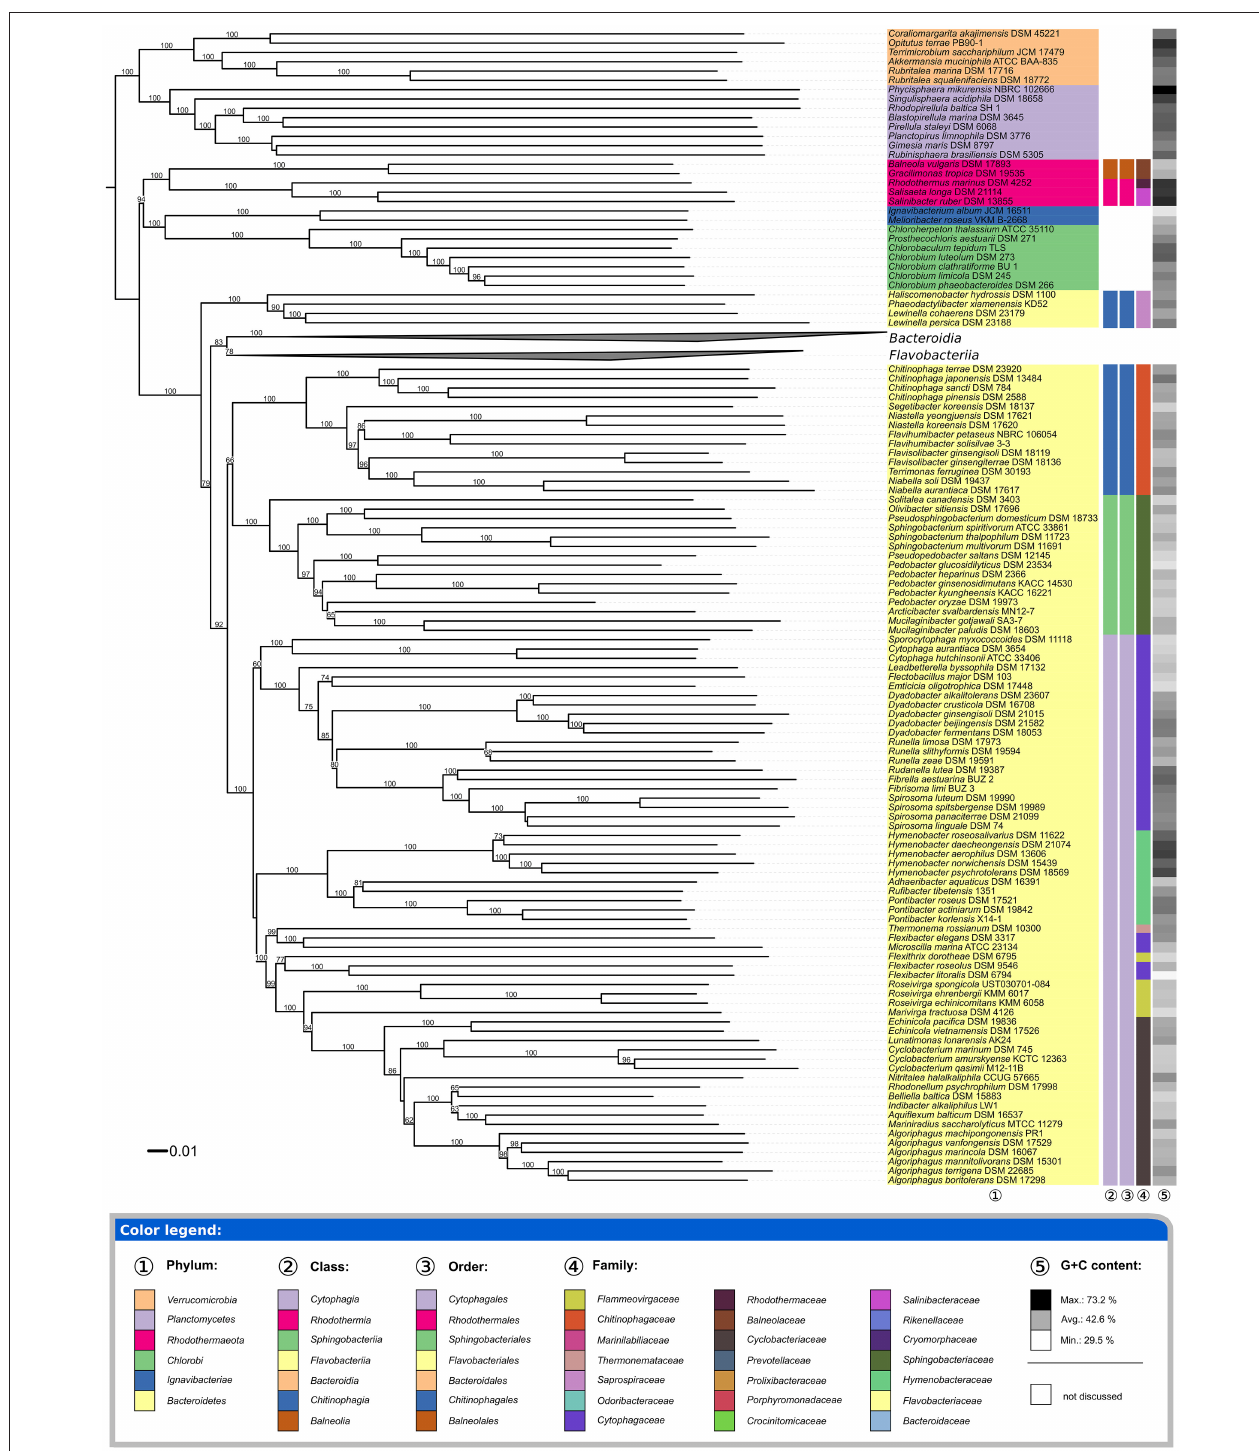
FIGURE 2 | First part of the phylogenomic tree inferred with GBDP. Tree inferred with FastME from GBDP distances calculated from whole proteomes. The numbers above branches are GBDP pseudo-bootstrap support values from 100 replications. Tip colors indicate the phylum, colors to the right of the ingroup tips indicate, from left to right, class, order and family (see the embedded legend for details). Gray scale on the very right indicates the exact G + C content as calculated from the genome sequences. The Bacteroidia and Flavobacteriia parts of the tree, which have been collapsed here, are shown in Figures 3 , 4 .